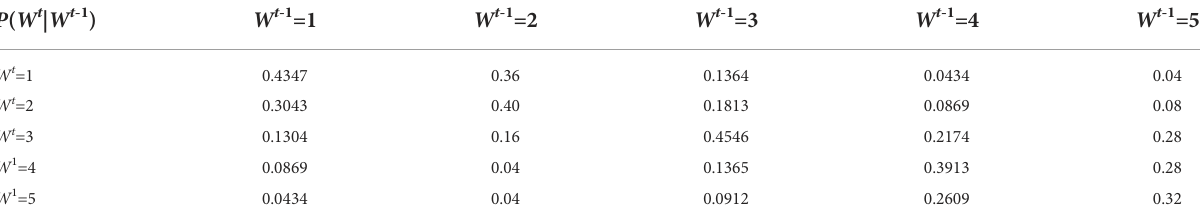
TABLE 6 Transition probability distribution of the output node W